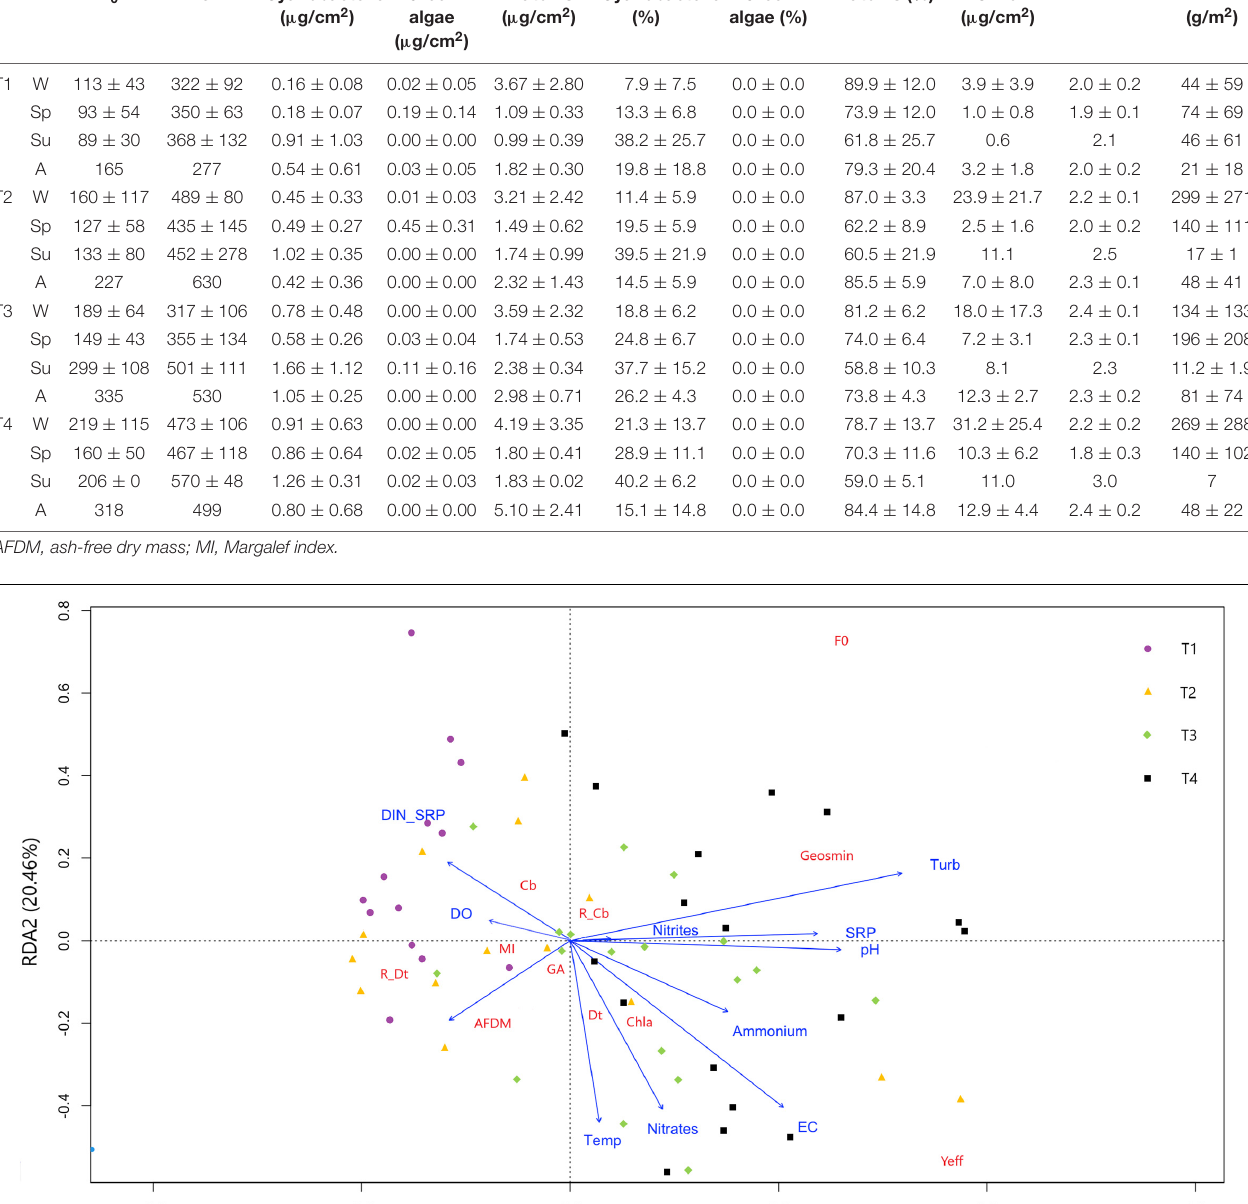
to be linked to the cyanobacteria presence in the biofilm (both absolute concentration and relative abundance), with higher values at the end of winter and in summer. Conversely,